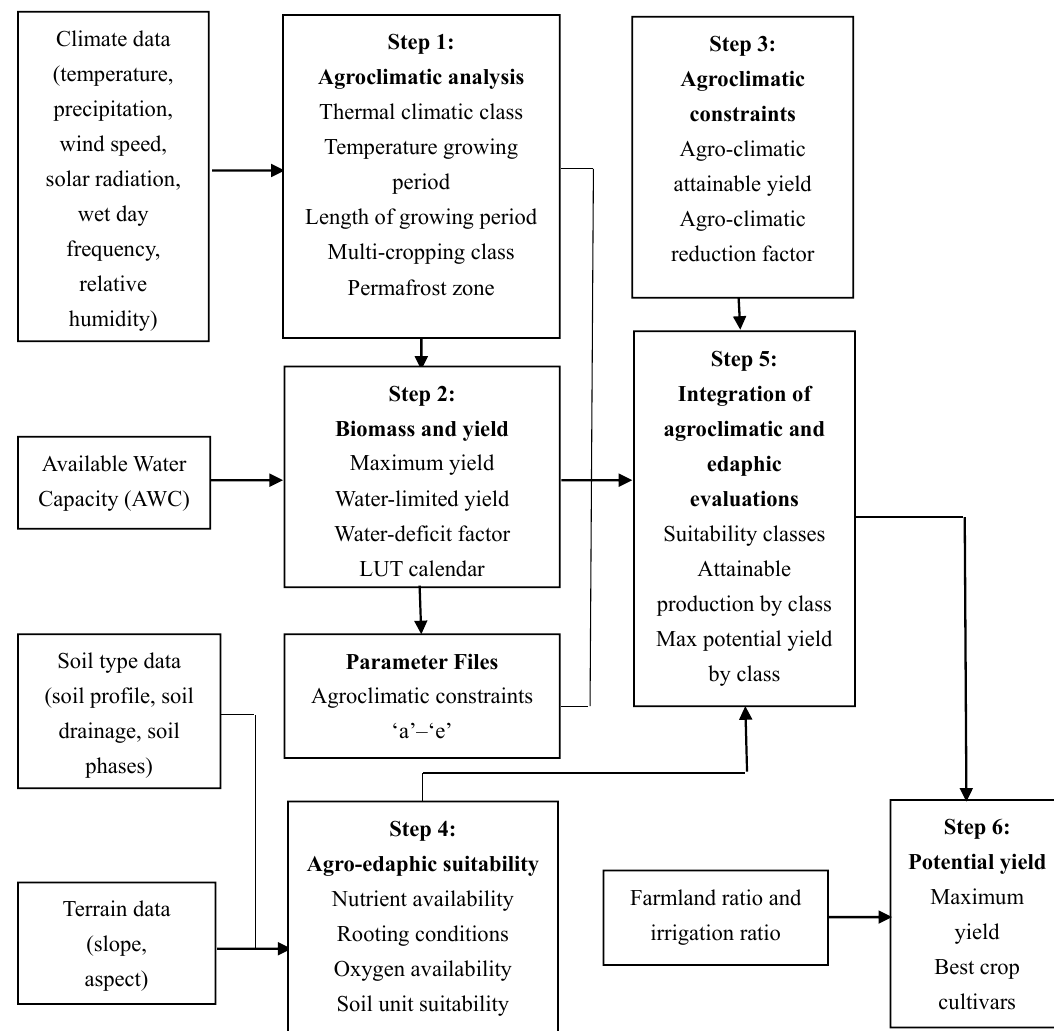
Figure 2. Procedures for calculating crop potential yield in the GAEZ model.